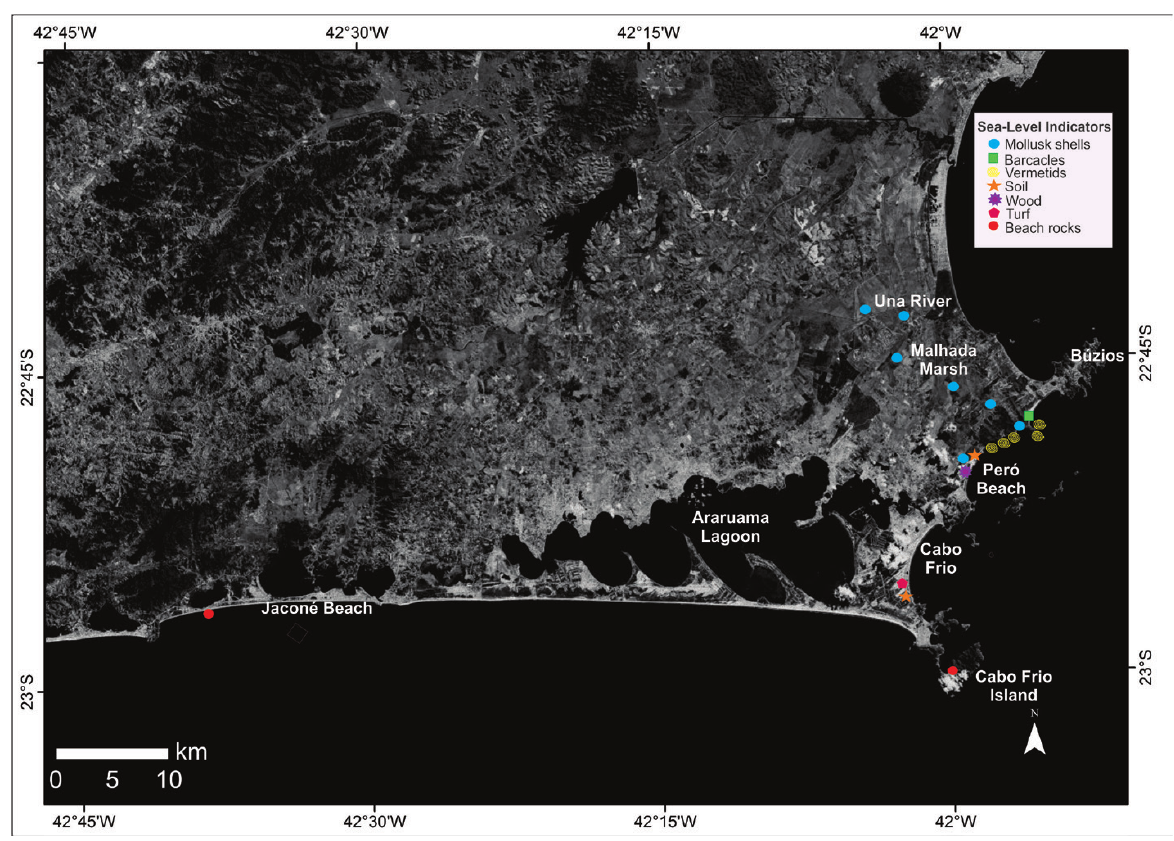
Figure 2 - Location of biological and geological samples in the Fluminenses Lakes region, central coast area in the state of Rio de Janeiro, southeastern